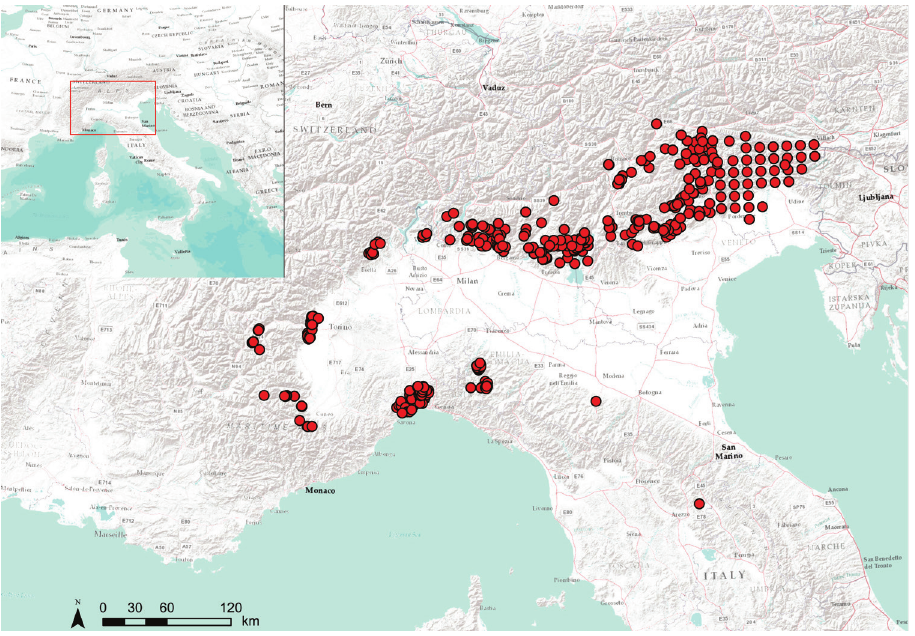
Figure 6. Geographic range and distribution map of Daphne cneorum in